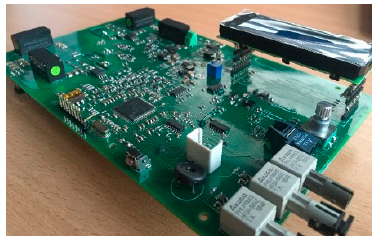
Figure 10. Photo of the developed digital control system.